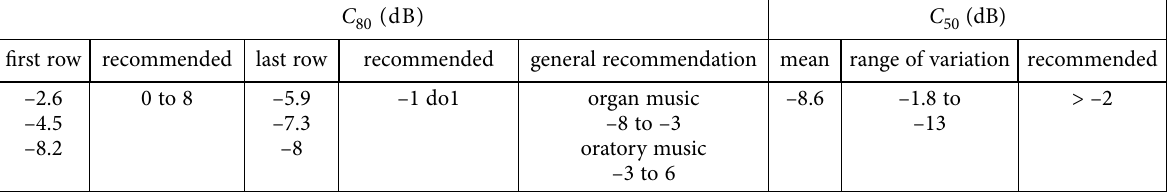
Table 2. Values of acoustic parameters C 80 and C 50 obtained from in situ measurements along with recommended values C 80 (dB)